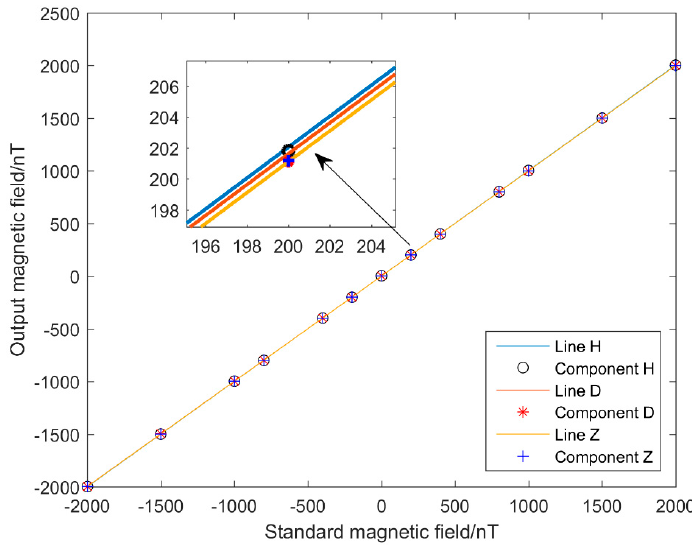
Figure 10. Linearity test results.